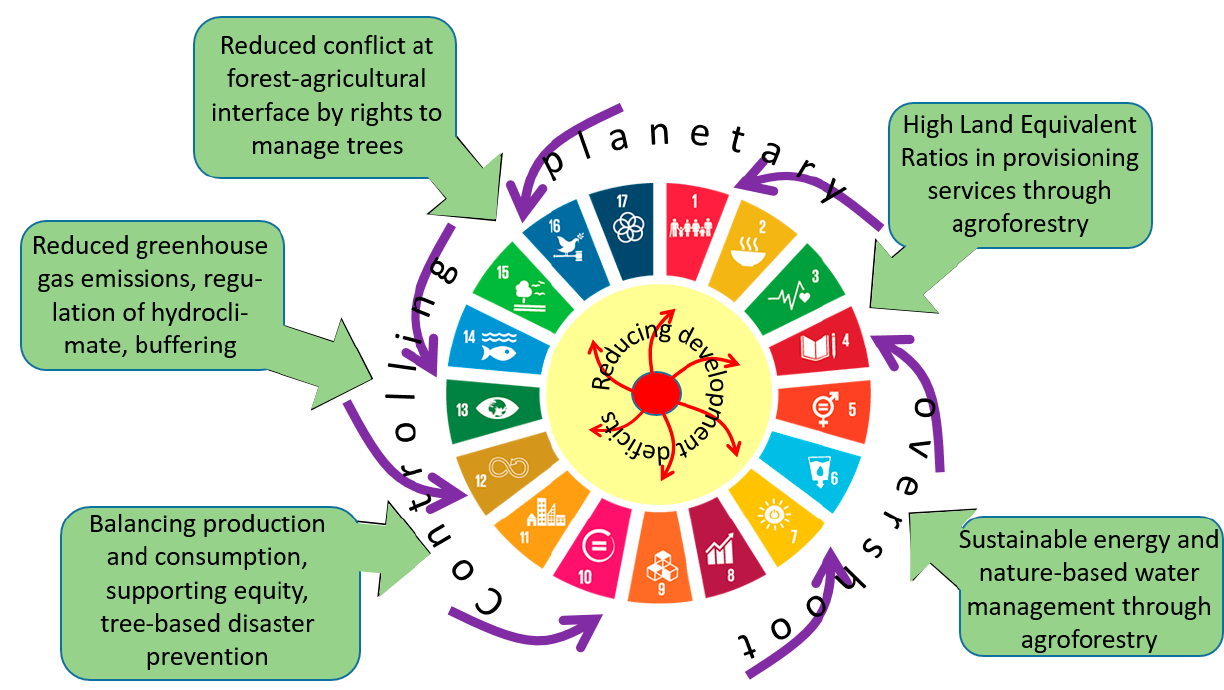
Figure 1. Agroforestry contributes to the various Sustainable Development Goals as safe space for humanity, between “development deficits” and “planetary boundary overshoot”.